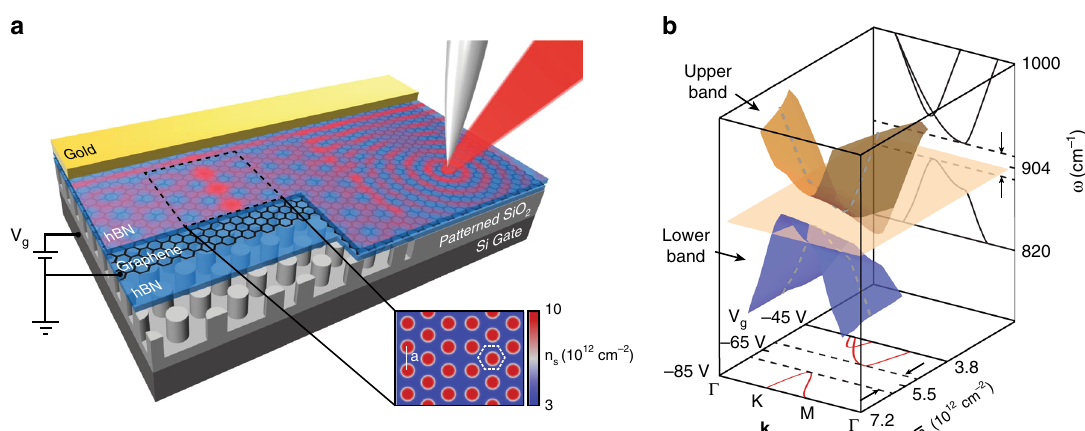
Fig. 1 Graphene photonic crystal. a Schematic of a photonic crystal comprised of a graphene monolayer fully-encapsulated by hexagonal boron nitride on top of an array of SiO 2 pillars. Inset, simulated carrier density map n s ( r ) at average carrier density (cid:1) n 4 : 5 ´ 10 12 cm (cid:2) 2 , showing two hexagonal-patterned s ¼ domains separated by an arti fi cial lattice dislocation (domain wall). The lattice periodicity a = 80 nm. The photonic crystal unit cell is marked by a white dashed hexagon. b Calculated plasmonic band structure as a function of wave-vector k and average carrier density (cid:1) n . A vertical cut parallel to the ω (cid:2) k s plane (back panel) generates the plasmonic band structure at fi xed carrier density (cid:1) n 5 : 5 ´ 10 12 cm (cid:2) 2 . The dashed lines mark the range of a complete s ¼ plasmonic bandgap. A horizontal cut parallel to (cid:1) n plane (bottom panel) generates the plasmonic dispersion as a function of average carrier density (cid:1) n s (cid:2) k s and wave-vector k , at laser frequency ω = 904 cm − 1 ; a complete bandgap is evident for carrier density around (cid:1) n 5 : 5 ´ 10 12 cm (cid:2) 2 s ¼